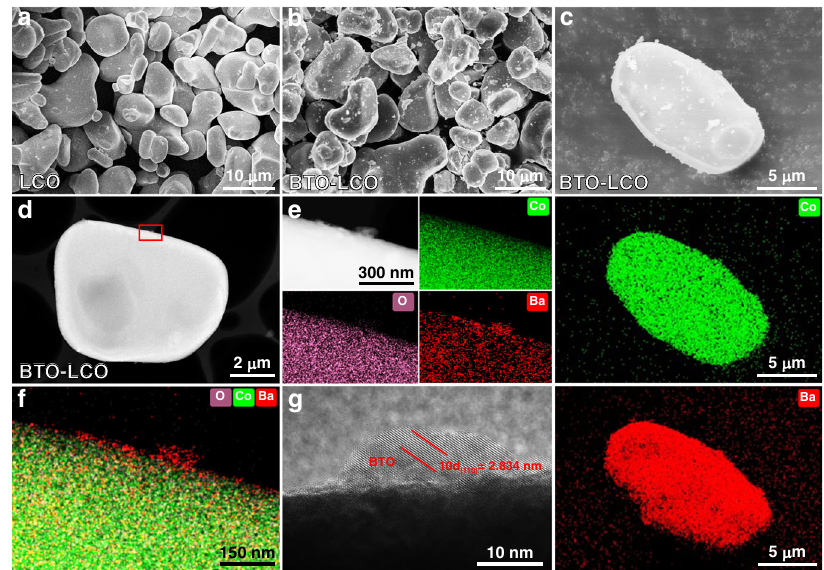
Fig. 2 Surface structure and composition of LCO and 5 at.% BTO – LCO. a , b Typical SEM images of LCO and BTO – LCO powders. c Typical SEM images and their EDS mappings of Co and Ba elements for a single BTO – LCO particle. d Typical HAADF-STEM image of a single BTO – LCO particle. e , f HAADF- STEM image and corresponding EDS mappings of Co, O, and Ba elements for the selected regions in d . g High-resolution HAADF-STEM image of the BTO – LCO particle